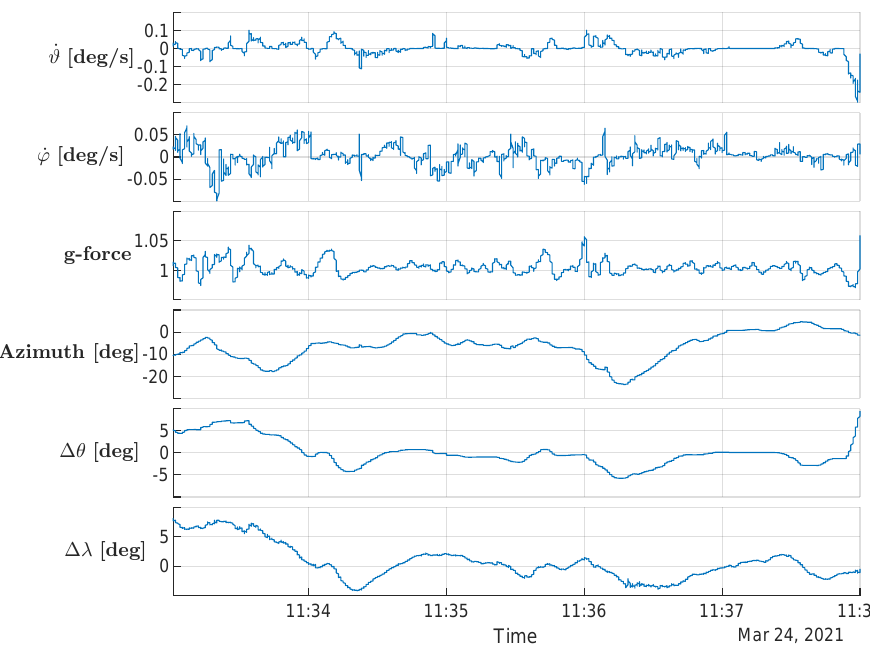
Figure 14. Measurements taken during the 5 min neutral flight period [20].